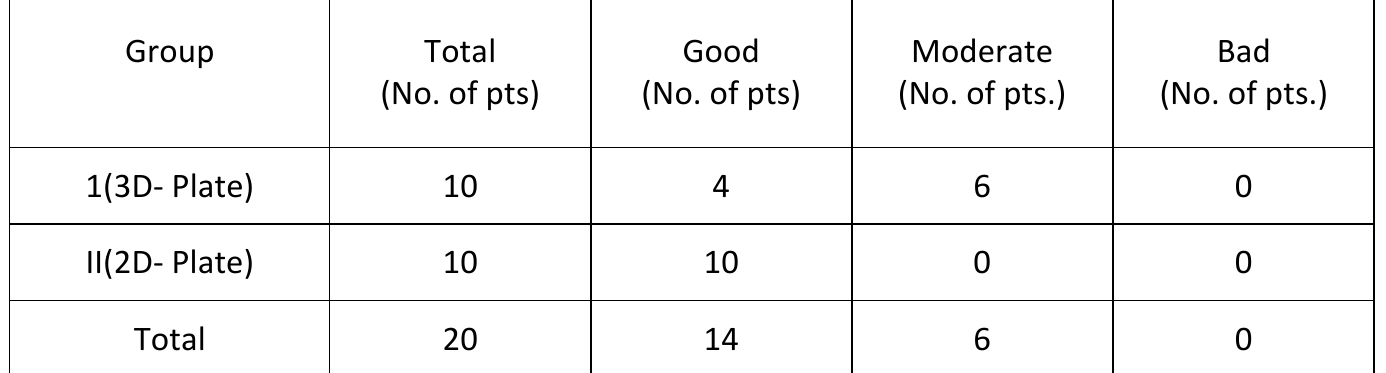
Table 2: Operator’s Comfort